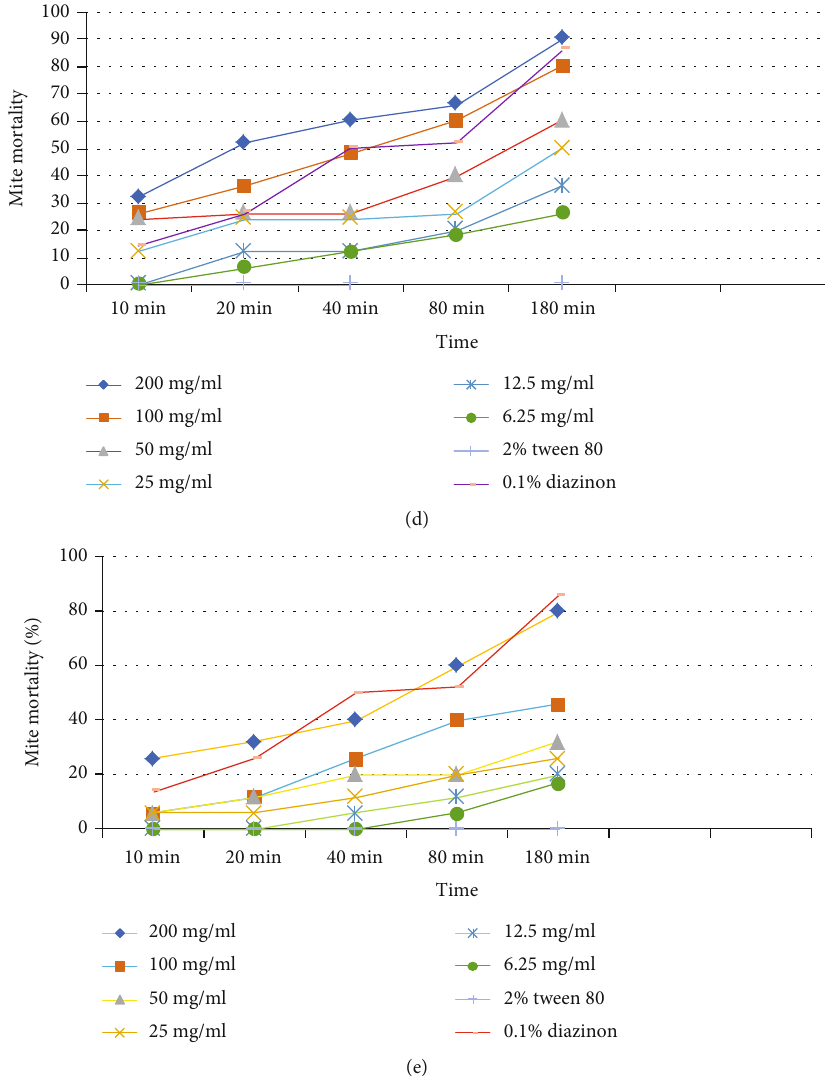
Figure 1: (a) Map representing the study area. (b) Mortalities of mites treated with the Dodonaea angustifolia crude extract. (c) Mortalities of mites treated with the Eucalyptus globulus essential oil extract. (d) Mortalities of mites treated with the Millettia ferruginea crude extract. (e) Mortalities of mites treated with the Euphorbia abyssinica c rude